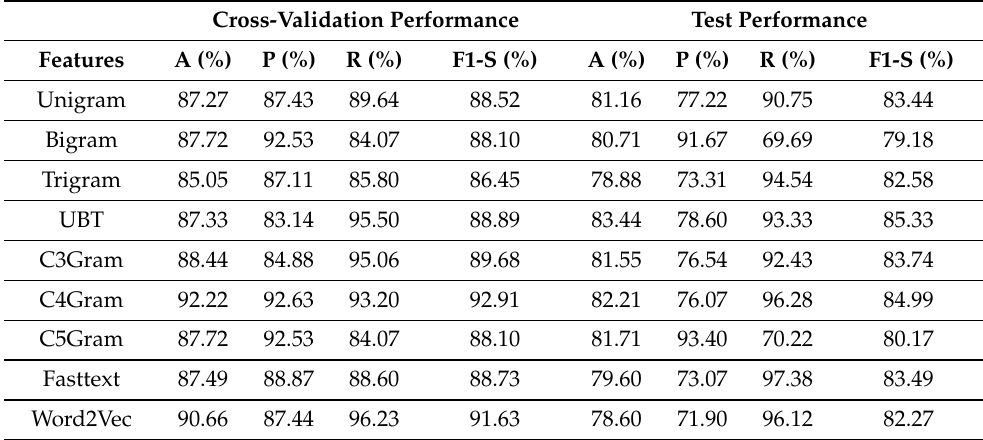
Table 7. Performance of Random Forest (RF) machine learning classifier.